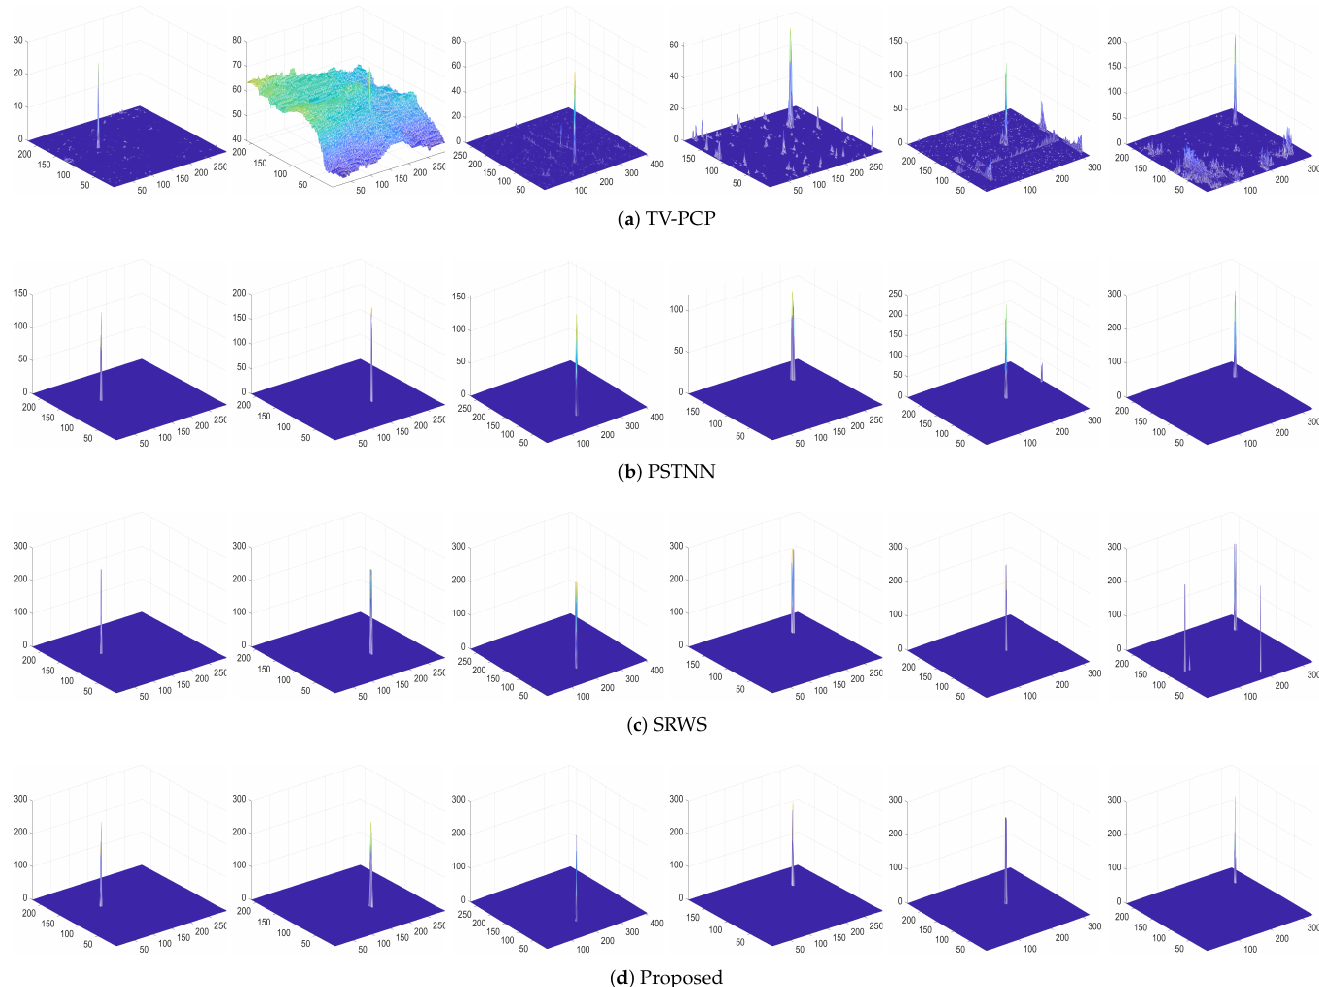
Figure 11. From left to right are the 3D gray images of the detection results of the 1 ∼ 6 sequences of images